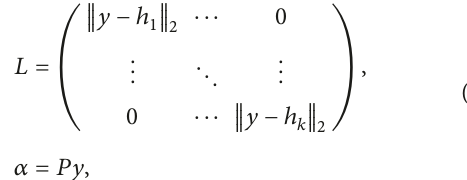
Figure 1: Three DCNNs architecture for a depth action sequence to extract